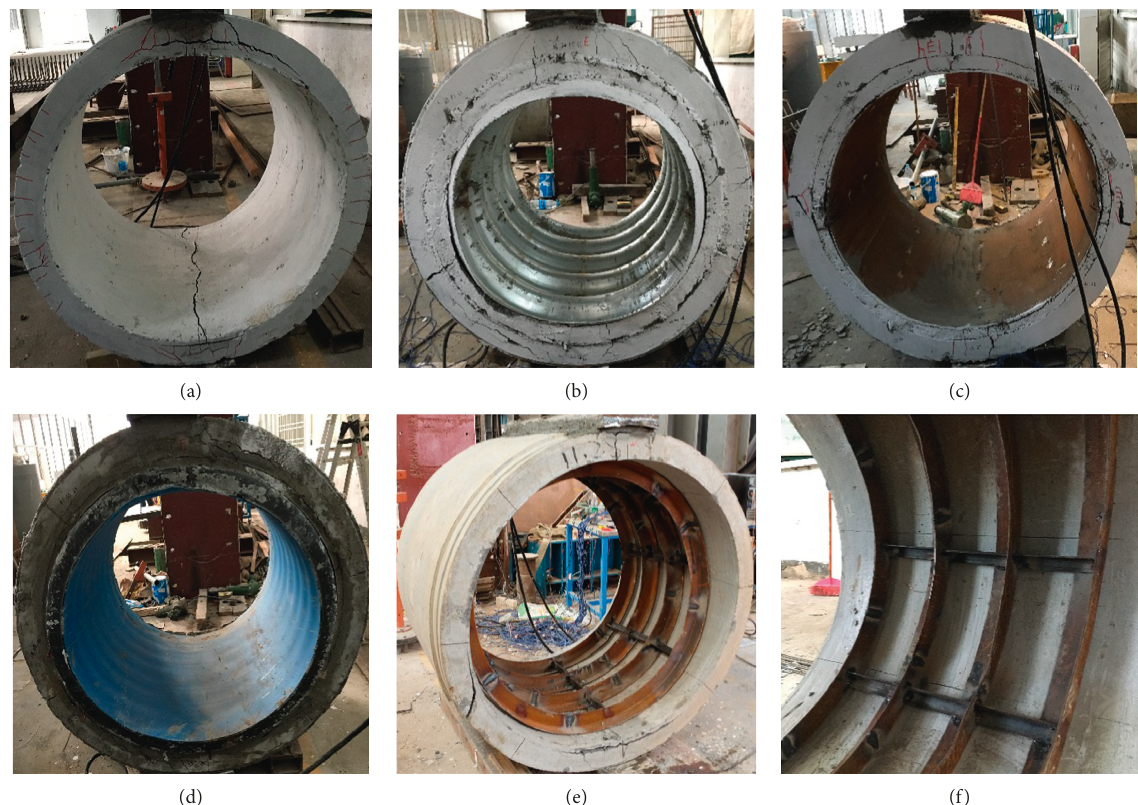
Figure 5: Cracks at the ends of the specimens: (a) RCP; (b) RGC; (c) RGS; (d) RGH; (e) RGB; (f) the buckling of the shape steel bracket.